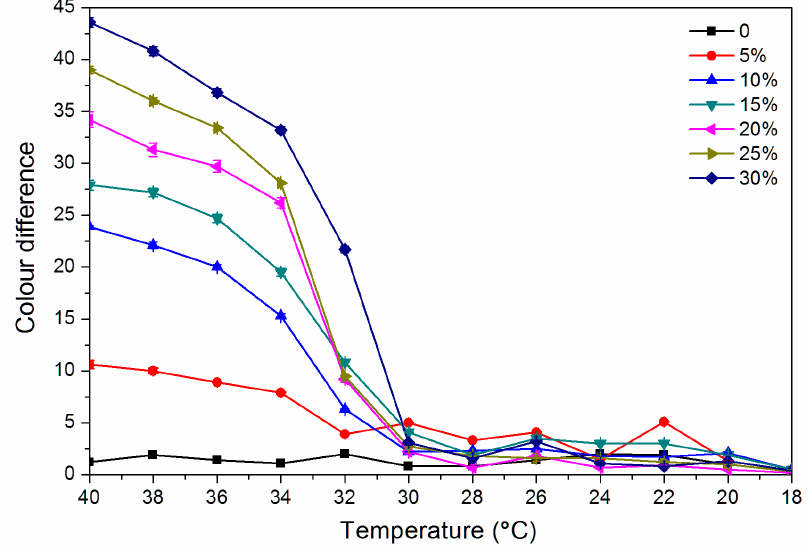
Figure 5. E ff ect of thermochromic ink concentration on colour di ff erence of waterborne finish film from Figure 5. Effect of thermochromic ink concentration on colour difference of waterborne finish film 40 to 18 ◦ from 40 to 18 ° C.